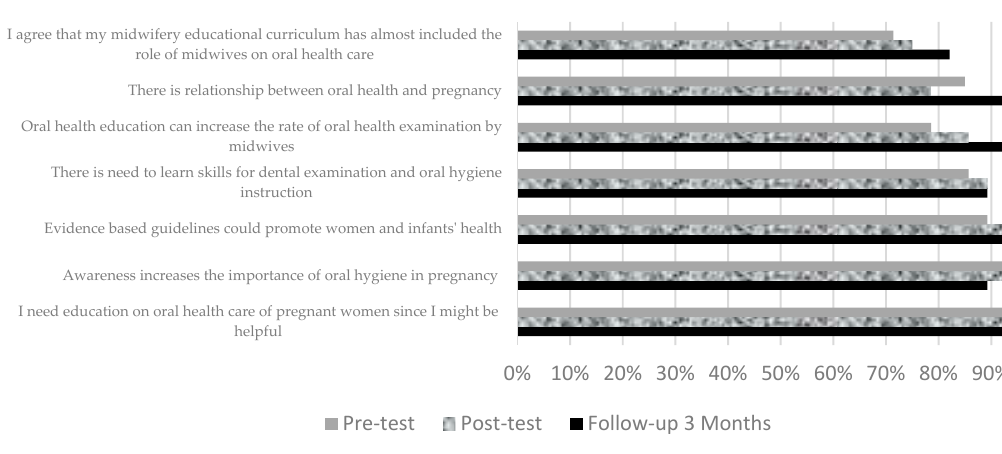
Figure 4. Comparison of positive attitude scores in the control group between pre-test, post-test, and follow-up 3 months.